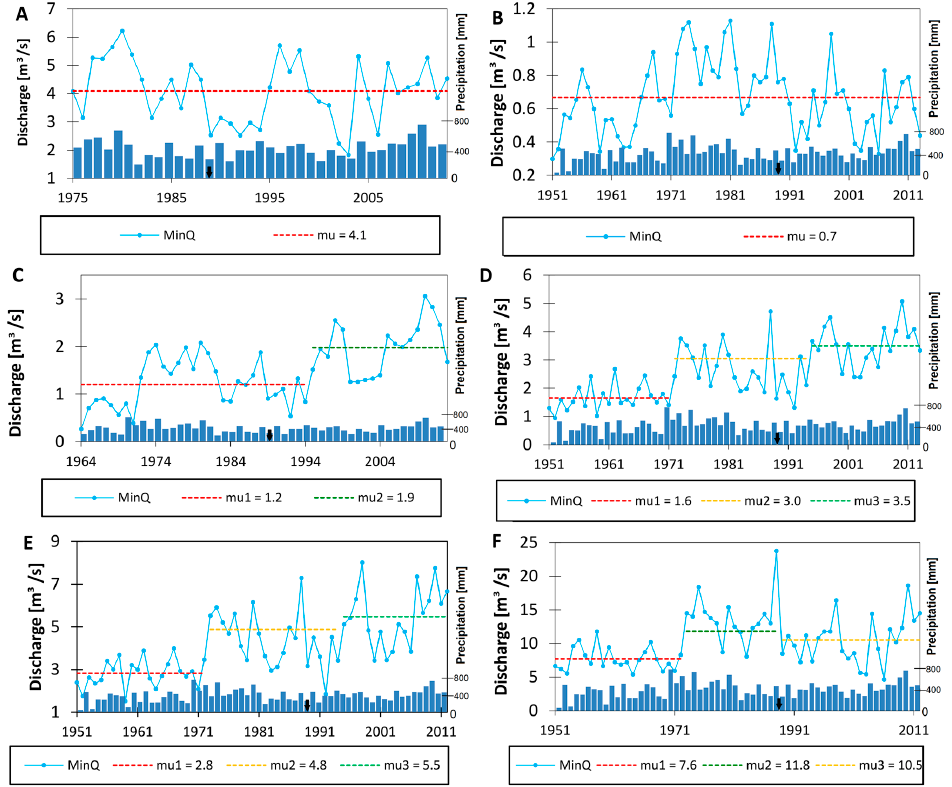
Figure 3. Annual minimum discharge for selected gauge stations of the Upper Narew Catchment: ( A ) Fasty, ( B ) Narewka, ( C ) Bondary, ( D ) Narew, ( E ) Sura ż , and ( F ) Str ę kowa Góra. “mu” stands for the average value of each time period. The black arrow indicates the year the SR started operation.